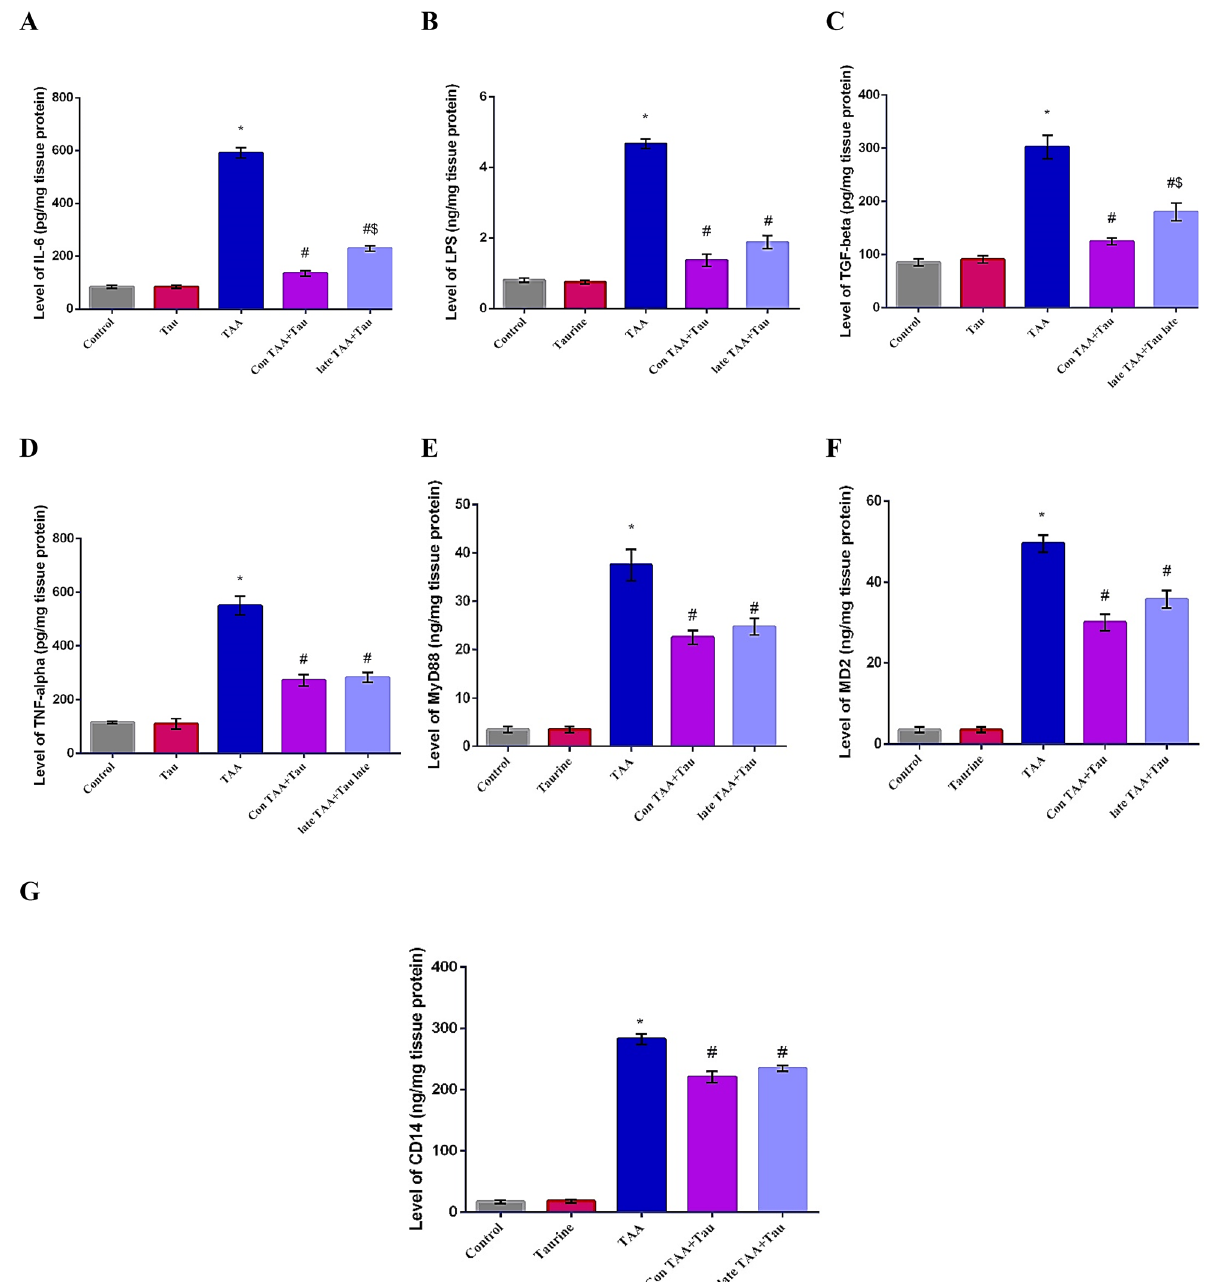
Figure 2. ( A ) Level of IL-6 in control, Tau, TAA, Con TAA + Tau and late TAA + Tau groups. ( B ) Level of LPS in control, Tau, TAA, Con TAA + Tau and late TAA + Tau groups. ( C) Level of IL-6, TGF-beta in control, Tau, TAA, Con TAA + Tau and late TAA + Tau groups. ( D ) Level of TNF-alpha in control, Tau, TAA, Con TAA + Tau and late TAA + Tau groups. ( E ) Level of MyD88 in control, Tau, TAA, Con TAA + Tau and late TAA + Tau groups. ( F ) Level of MD2 in control, Tau, TAA, Con TAA + Tau and late TAA + Tau groups. ( G ) Level of CD14 in control, Tau, TAA, Con TAA + Tau and late TAA + Tau groups. Values were expressed as mean ± SE. Number of rats in each group was 6. IL-6: interleukin-6, LPS: lipopolysaccharides, TGF-beta: transforming growth factor-beta, TNF-alpha: tumor necrosis factor-alpha, CD14: Cluster of Differentiation 14, MyD88: Myeloid Differentiation primary response protein, MD2: myeloid differentiation protein 2. Tau: taurine, TAA: thioacetamide *: Significance against control group ( P < 0.05), # Significance against TAA group ( P < 0.05), $: Significance against Con TAA + Tau group ( P <